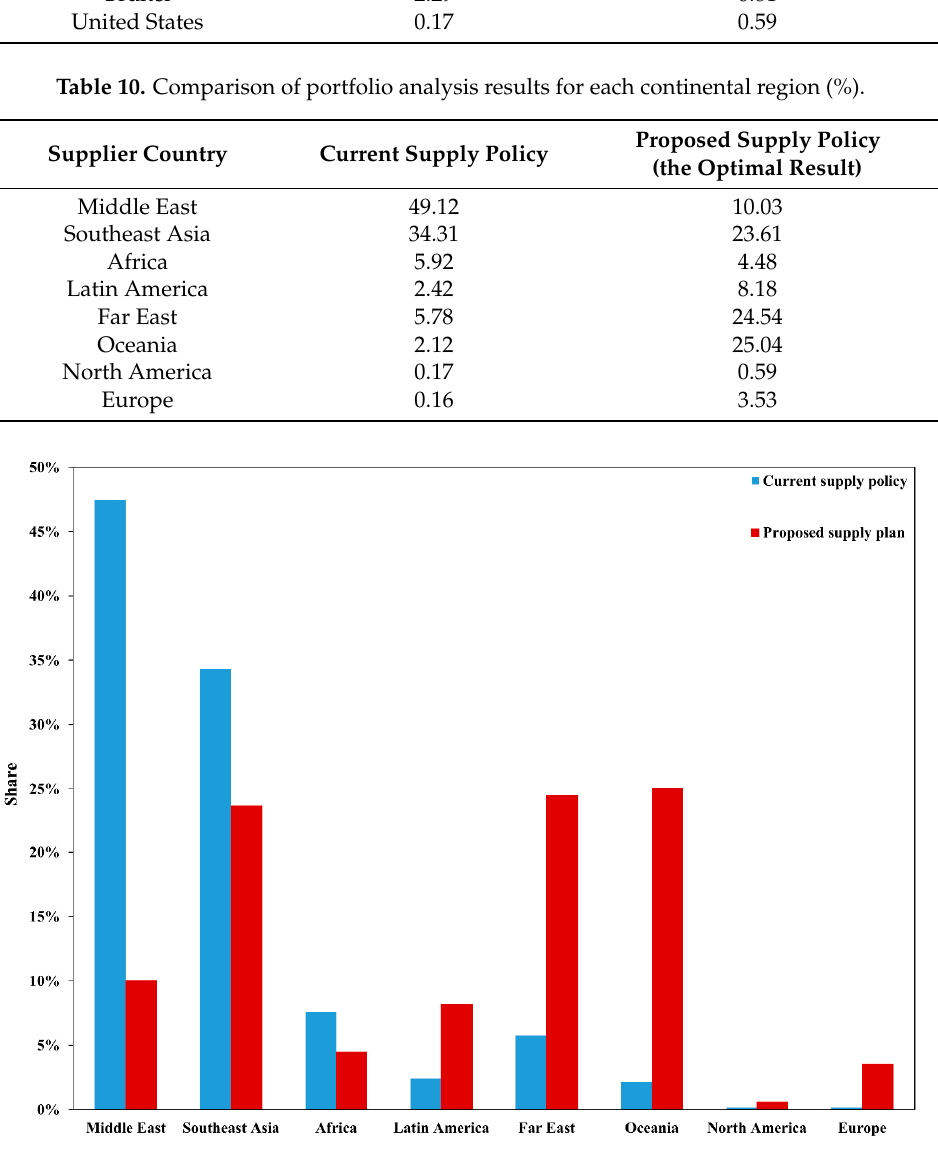
Figure 5. Comparison of portfolio analysis results for each continental region. Table 10. Comparison of portfolio analysis results for each continental region (%).